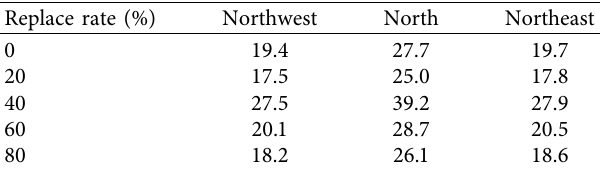
Table 10: Prediction of frost resistance and durability life of iron ore tailings